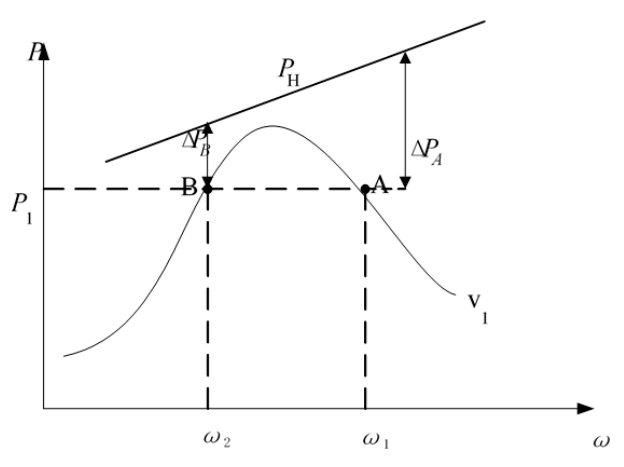
Figure 1. Power tracking curve of DFIG at different wind speeds.